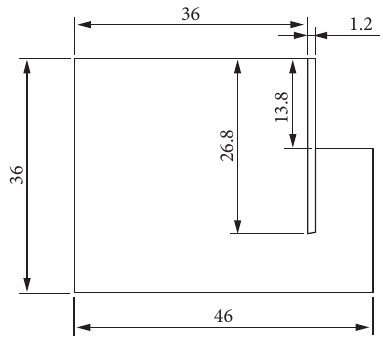
Figure 1: Illustration of the model. Table 1: Particle